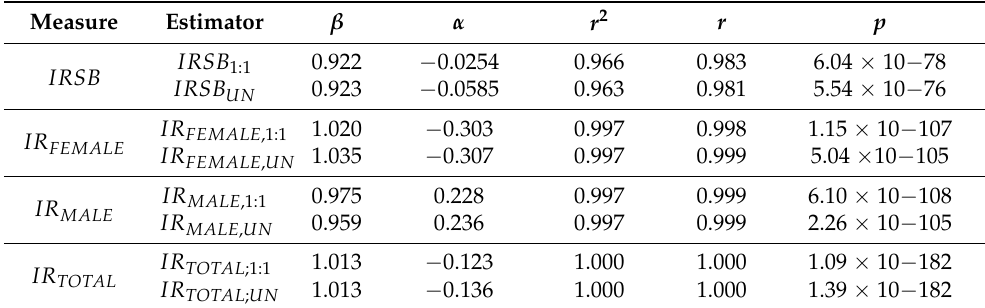
Table 2. Pearson’s correlation coefficient and simple linear model results for estimators. For each measure, each of two estimators (with sex ratio as 1:1 or from the United Nations estimates) is shown with its simple linear model coefficient β , intercept α , and r 2 , and its Pearson’s correlation coefficient r and one-sided t -test p